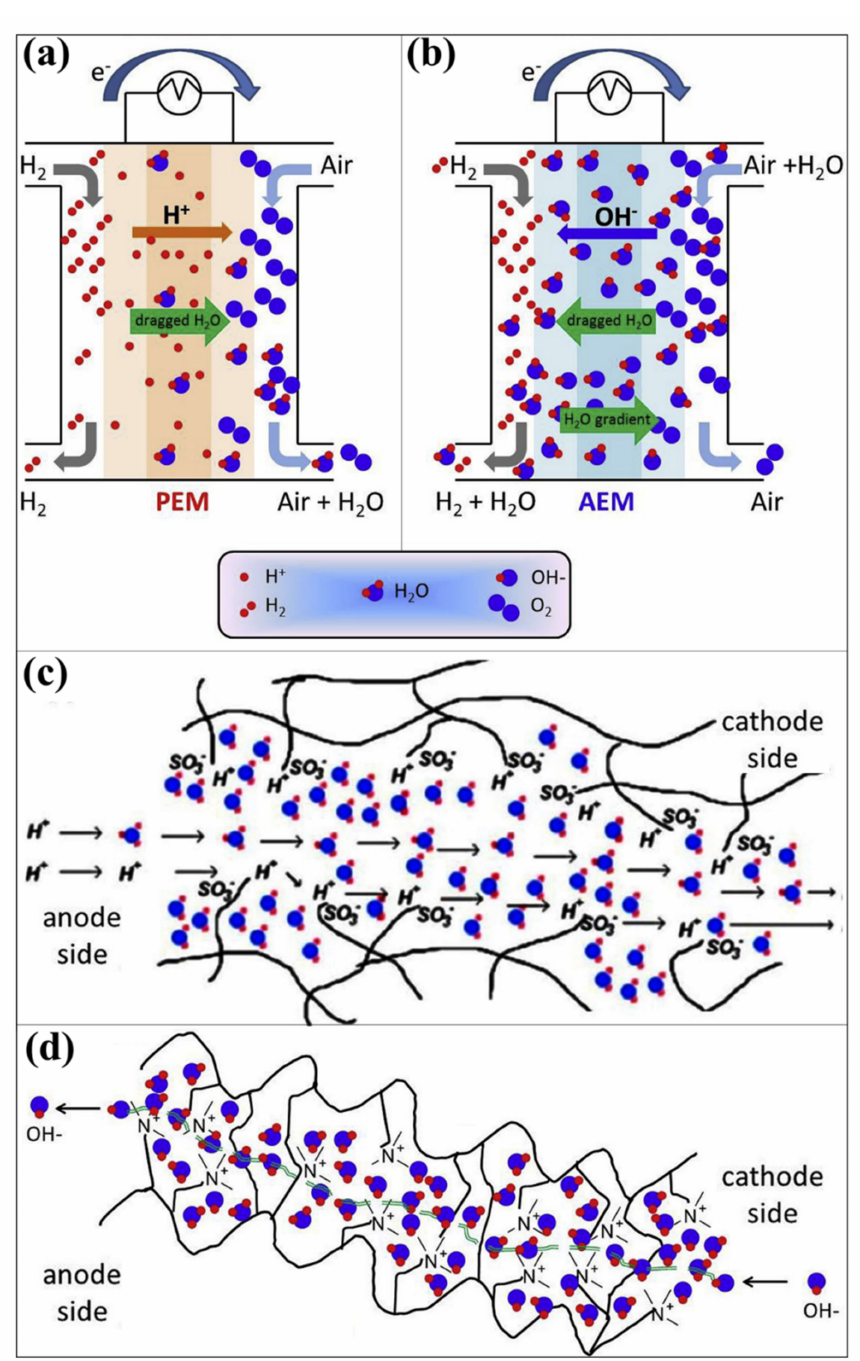
Figure 1. Schematic representation of ( a ) PEMFC and ( b ) AFC working mechanism. ( d )